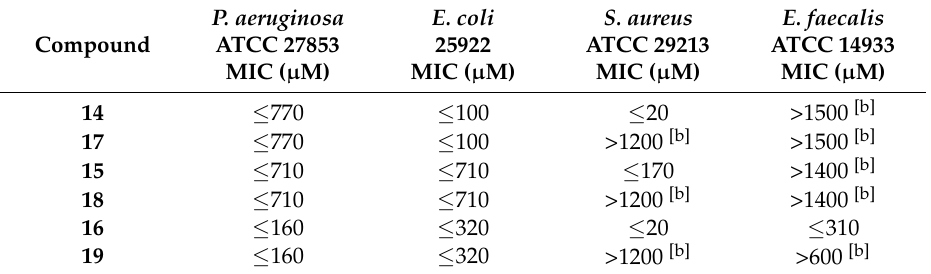
Table 2. Measured minimum inhibitory concentration (MIC) values for FNs 14 – 16 and FMs 17 – 19 against Gram-negative P. aeruginosa and E. coli , and Gram-positive S. aureus and E. faecalis [a]